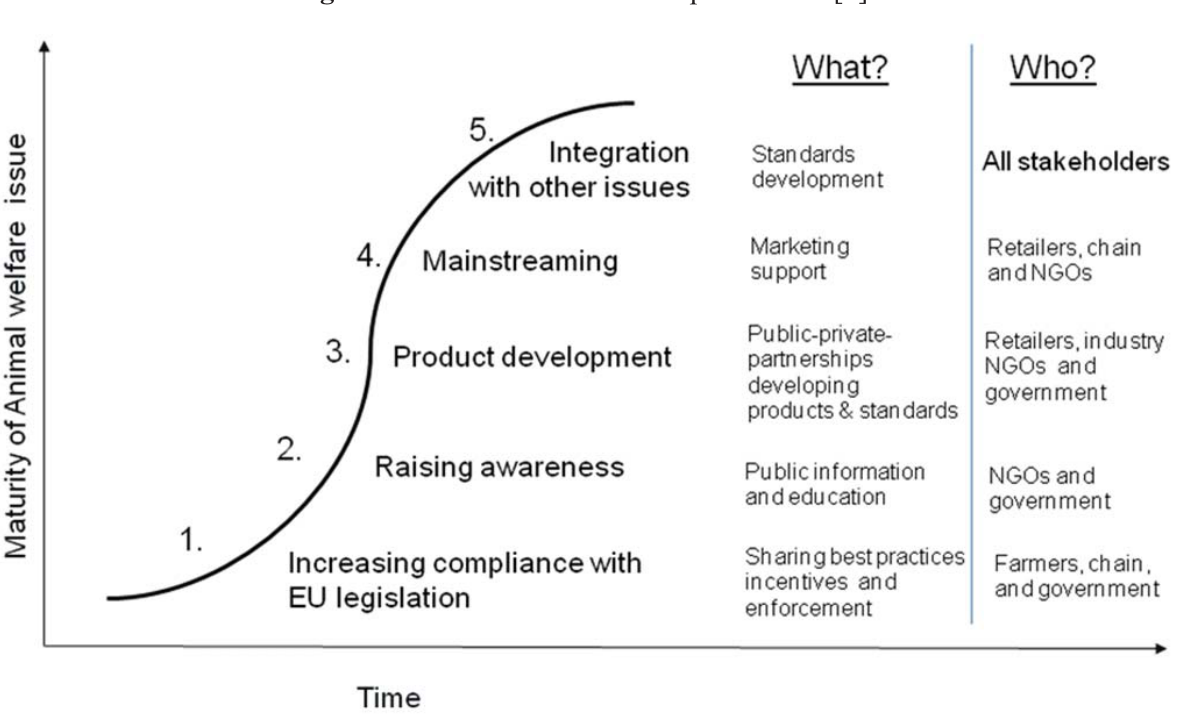
Figure 1. Animal welfare development road